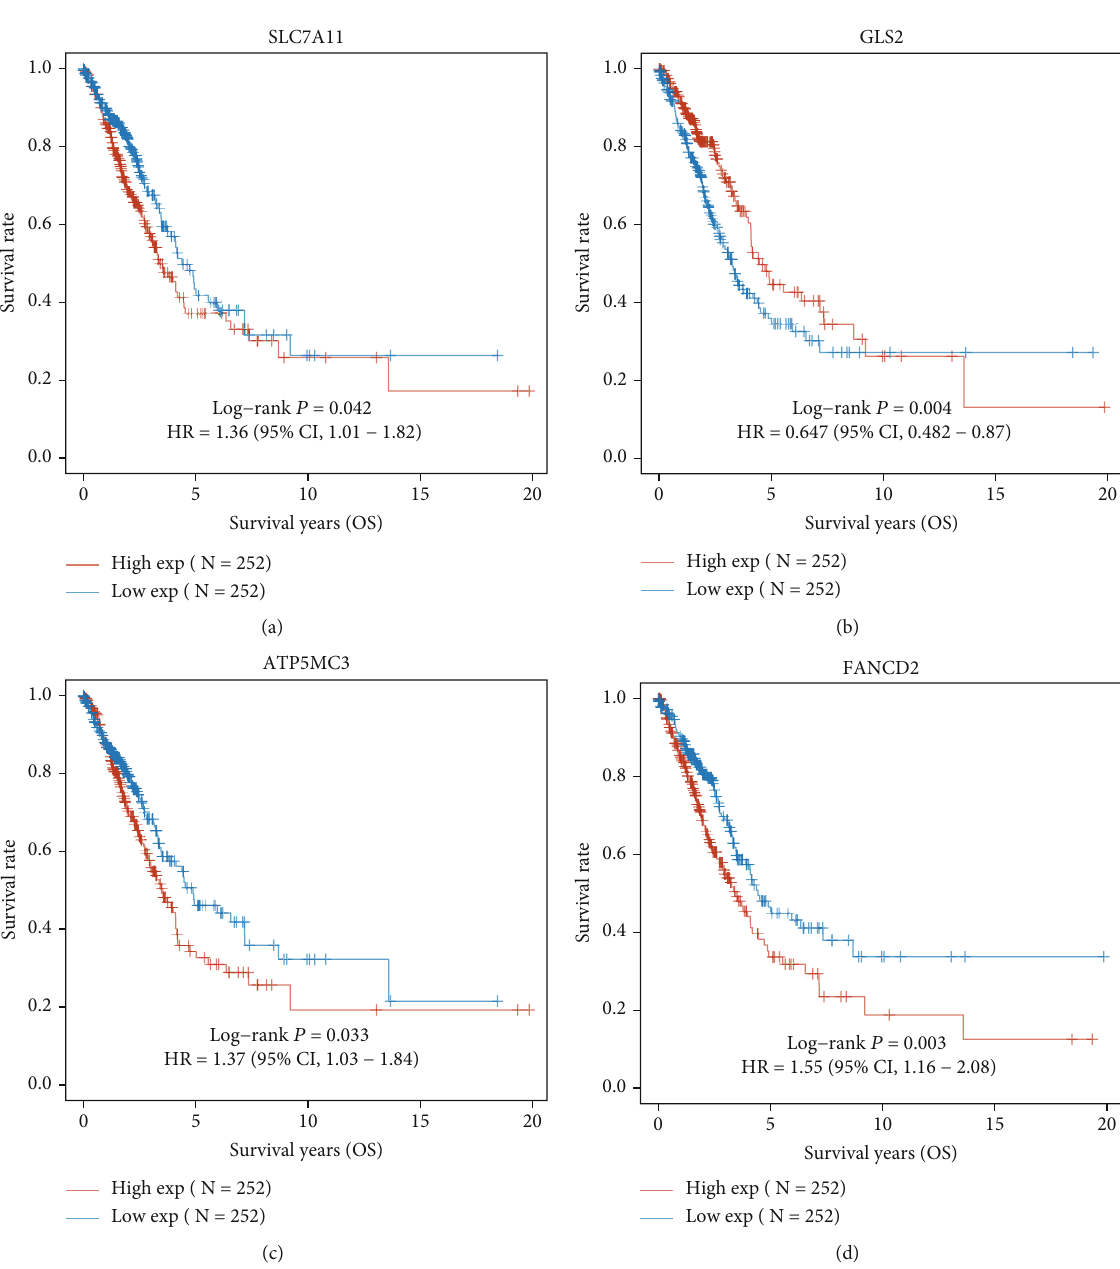
Figure 2: The survival-associated genes in LUAD were identi fi ed using Kaplan-Meier methods, including (a) SLC7A11, (b) GLS2, (c) ATP5MC3, and (d)